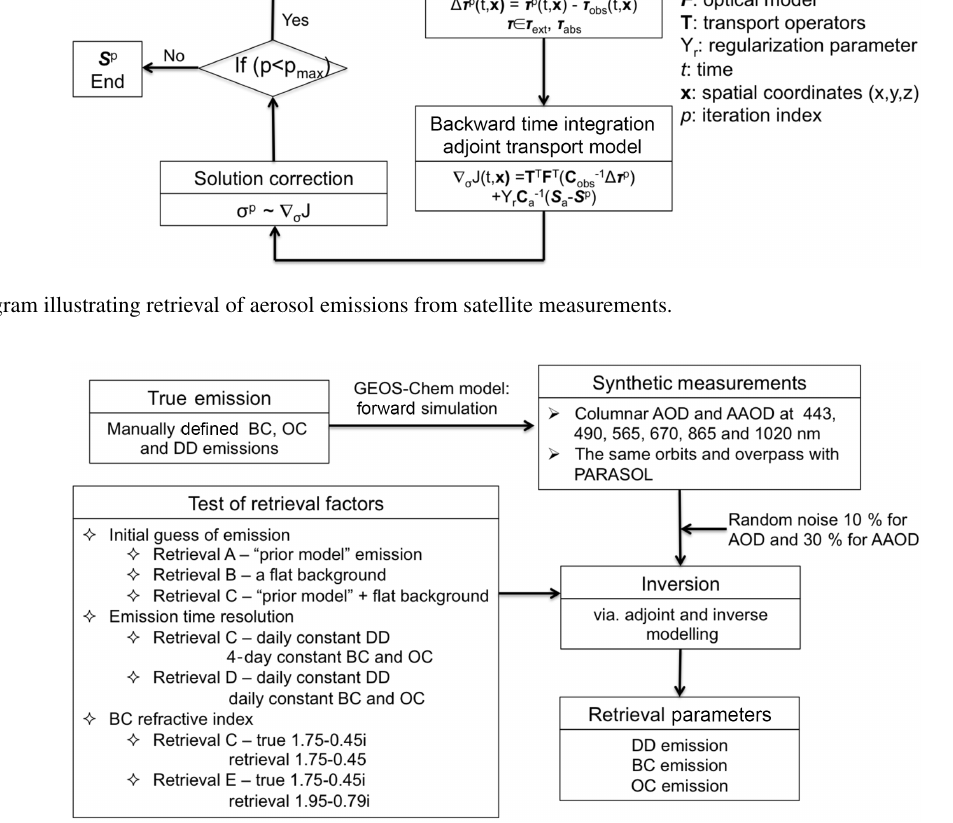
Figure 5. Diagram illustrating the inversion tests from synthetic